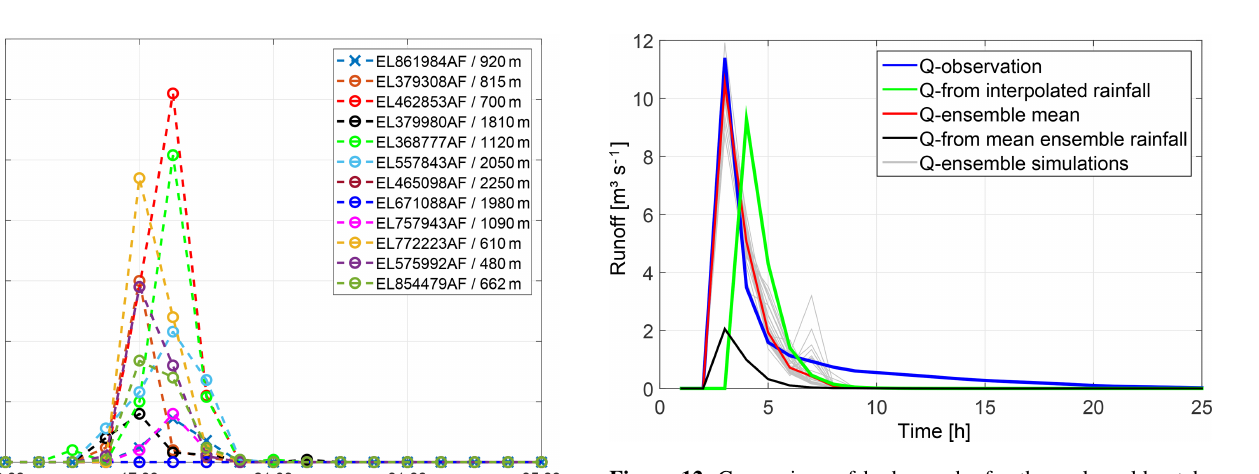
Figure 12. Comparison of hydrographs for the real-world catch- ment shown by the observed runoff (blue) and rainfall–runoff simu- lation results based on interpolated rainfall patterns (green), a sim- ulated ensemble of spatio-temporal rainfall patterns conditioned at rainfall and runoff observations (grey) and their mean value (red), and mean ensemble rainfall patterns